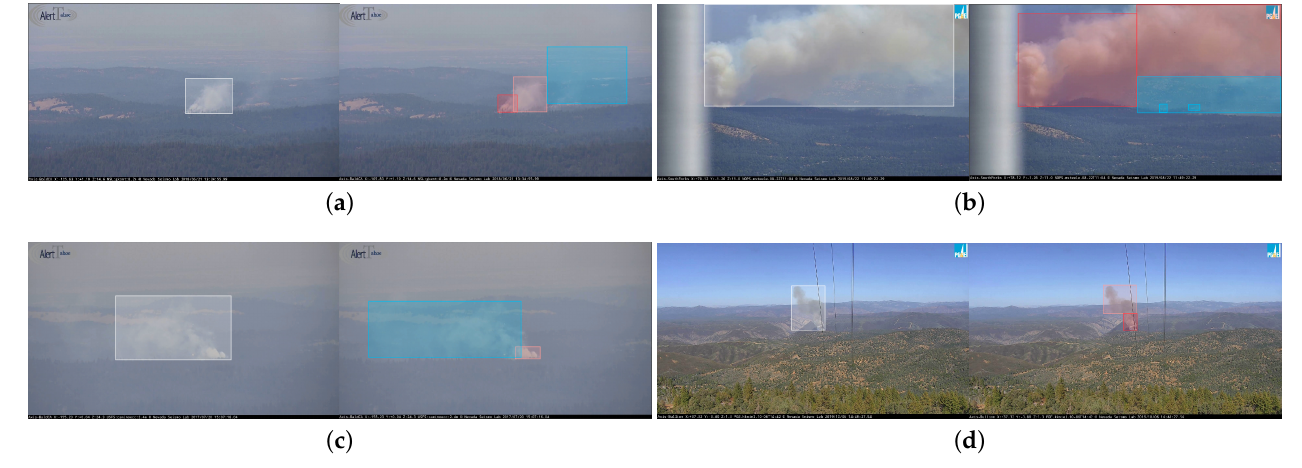
Figure 6. Examples of smoke density re-annotation. The left side shows our initial annotation with the single category “smoke” (bounding box denoted with white color). On the right side, the same images were re-annotated with smoke as the super-category, and “low” (blue), “mid” (pink), and “high” (red) as the categories based on the relative opacity of the smoke. ( a ) Axis-Bald-Mtn-CA 2018-06-21 13:34. ( b ) Axis-SouthForks 2019-08-22 11:49. ( c ) Axis-Bald-Mtn-CA Placerville 2017-07-20 15:07. ( d ) Axis-Bullion Briceburg fire 2019-10-06